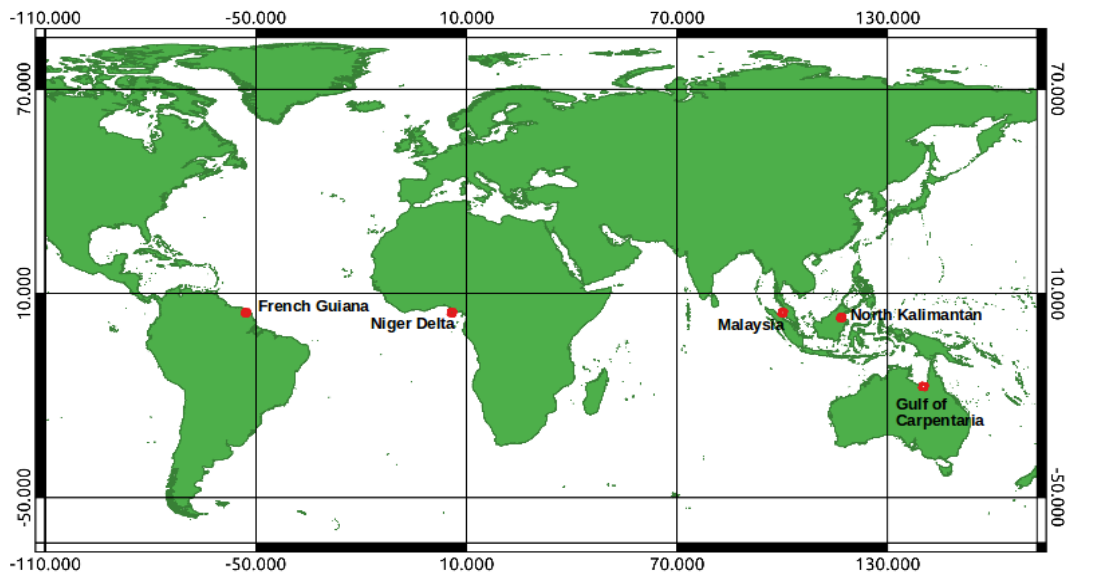
Figure 1. Location of the five study